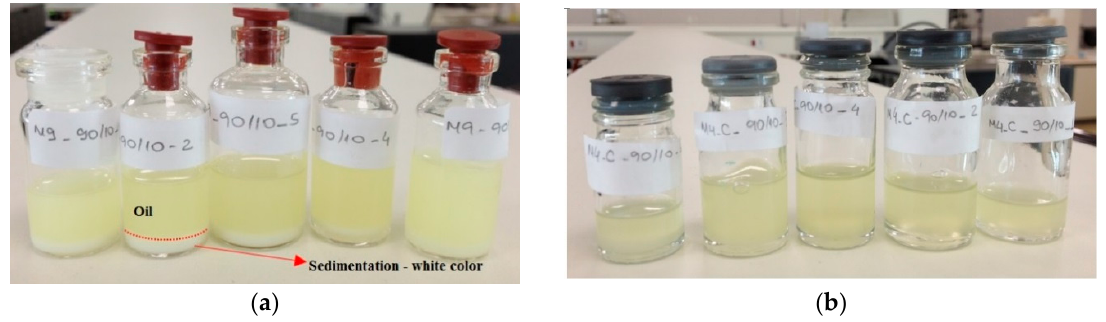
Figure 9. Water-in-diesel nanoemulsion: ( a ) fuel with 5% of surfactant, which it is possible to observe a white sedimentation and ( b ) fuel with 10% of surfactant with a translucent aspect.